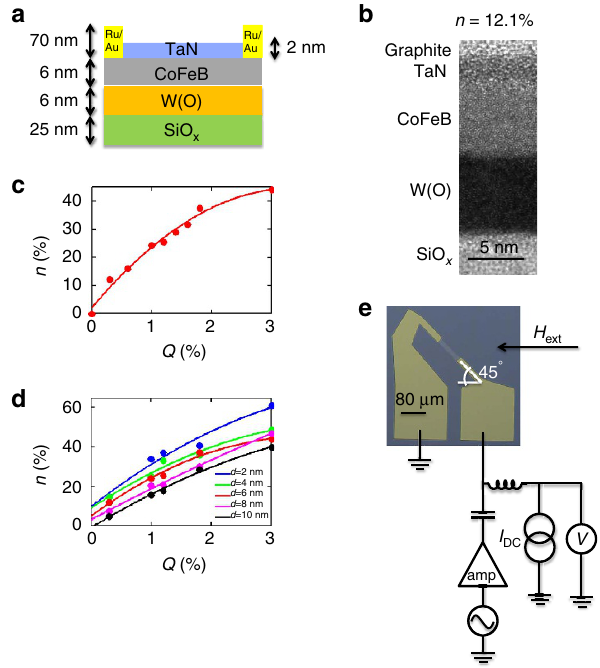
Figure 1 | STFMR measurement. ( a ) Device structure consisting of substrate | W(O) (6) | Co 40 Fe 40 B 20 (6) | TaN (2) (with film thickness in parantheses in nm). ( b ) Cross-section transmission electron microscope (TEM) image of the device structure for n ¼ 12.1% ( Q ¼ 0.3%). ( c ) Oxygen concentration n is plotted against gas flow Q as determined by Rutherford backscattering spectrometry (RBS). ( d ) Oxygen concentration versus gas flow Q for W(O) films of different thicknesses. ( e ) Microscope image and schematic of the electrical circuit used for STFMR